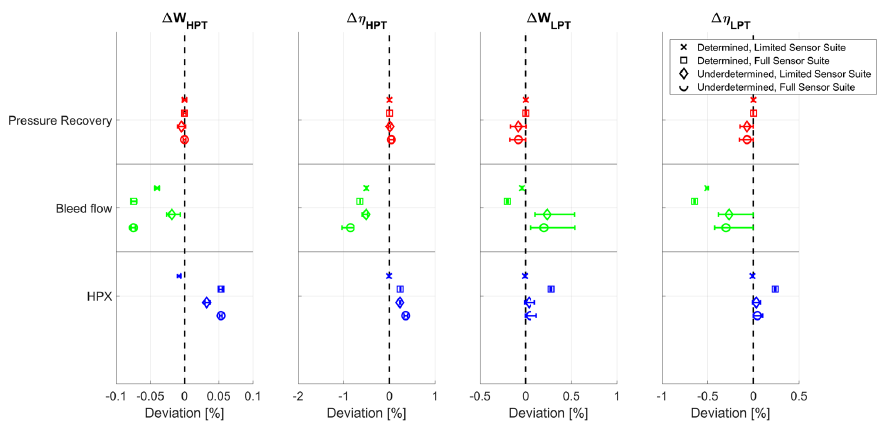
Figure 11. Turbine sensitivity to erroneous installation effects.